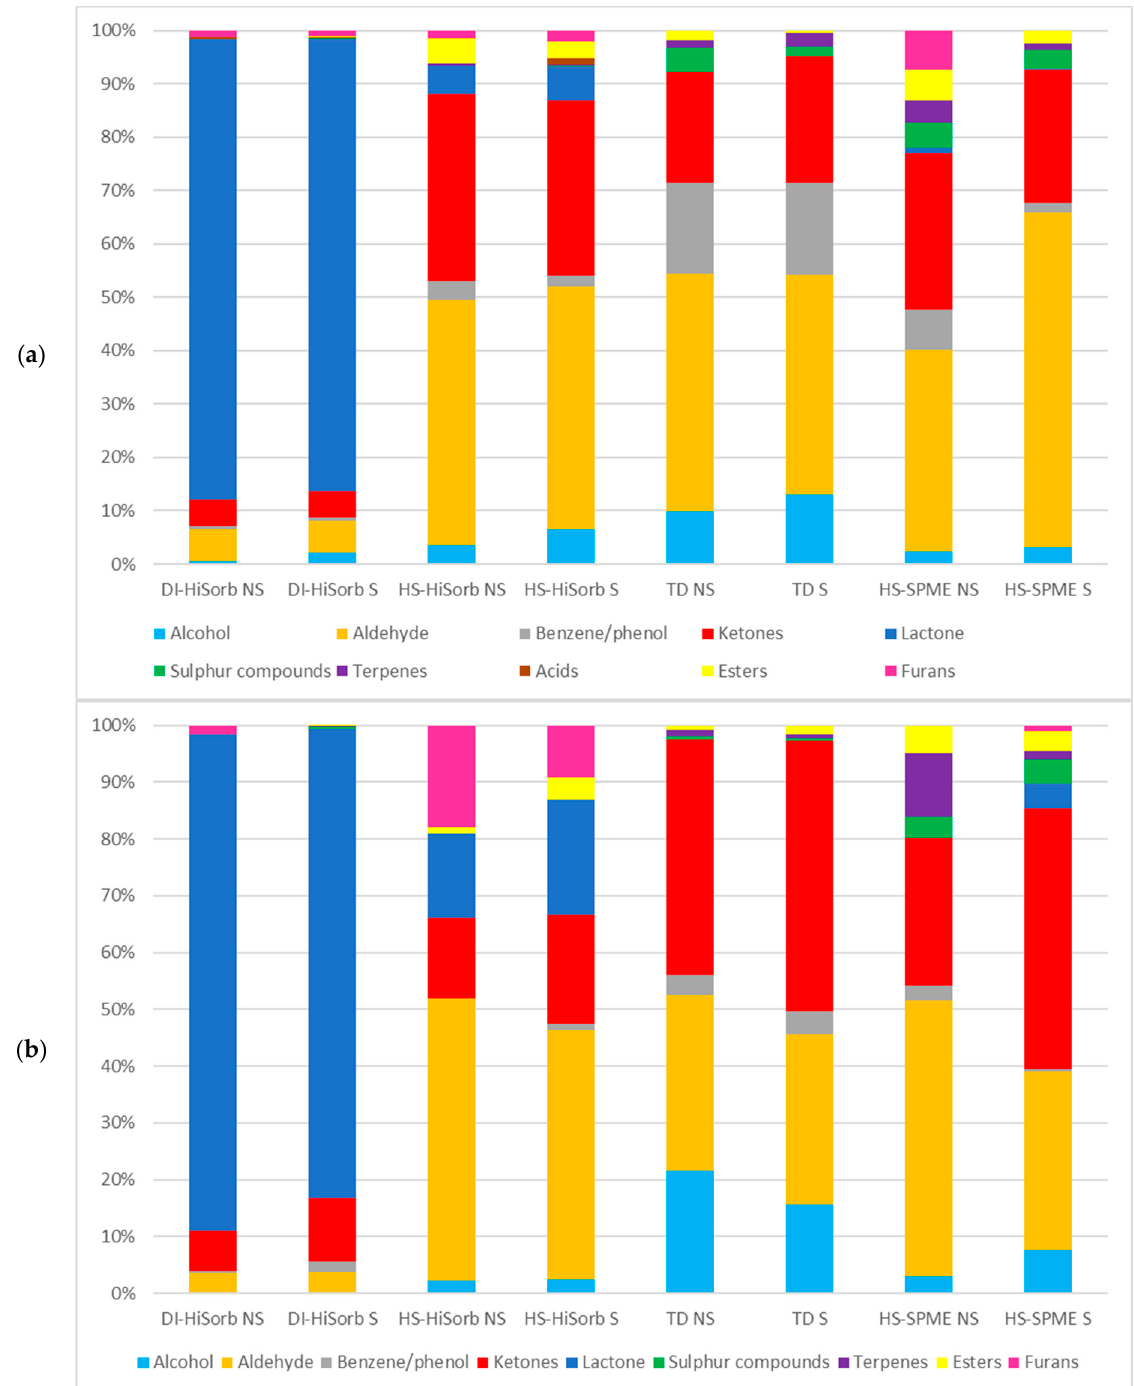
Figure 1. ( a ) The percentage of each chemical class extracted by the four extraction techniques using the non-polar GC column with and without salting out, and ( b ) the percentage of each chemical class extracted by the four extraction techniques using the polar GC column with and without salting out. Direct Immersion HiSorb without salting out (DI-HiSorb NS), Direct Immersion HiSorb with salting out (DI-HiSorb S), Headspace HiSorb without salting out (HS-HiSorb NS), Headspace HiSorb with salting out (HS-HiSorb S), Thermal Desorption without salting out (TD-NS), Thermal Desorption with salting out (TD S), Headspace Solid Phase Microextraction without salting out (HS-SPME NS), Headspace Solid Phase Microextraction with salting out (HS-SPME S).